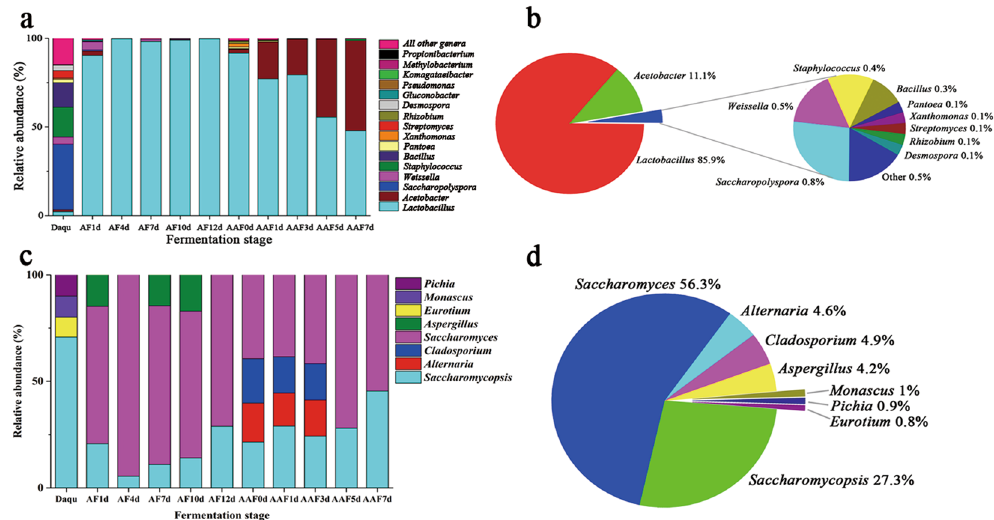
Figure 1. Succession of microbial community in different fermentation stages of Shanxi aged vinegar (SAV). ( a ) The distribution of major genera in the bacterial communities of different fermentation stages. ( b ) The total percentage of dominant bacterial genera in all specimens of SAV. ( c ) The distribution of major genera in the fungal communities of different fermentation stages. ( d ) The total percentage of dominant fungal bacterial genera in all specimens of SAV. Daqu represents the daqu specimen, AF1d–AF12d represent specimens from 1 day to 12 days of alcohol fermentation, and AAF0d–AAF7d represent specimens from 0 day to 7 days of acetic acid fermentation.